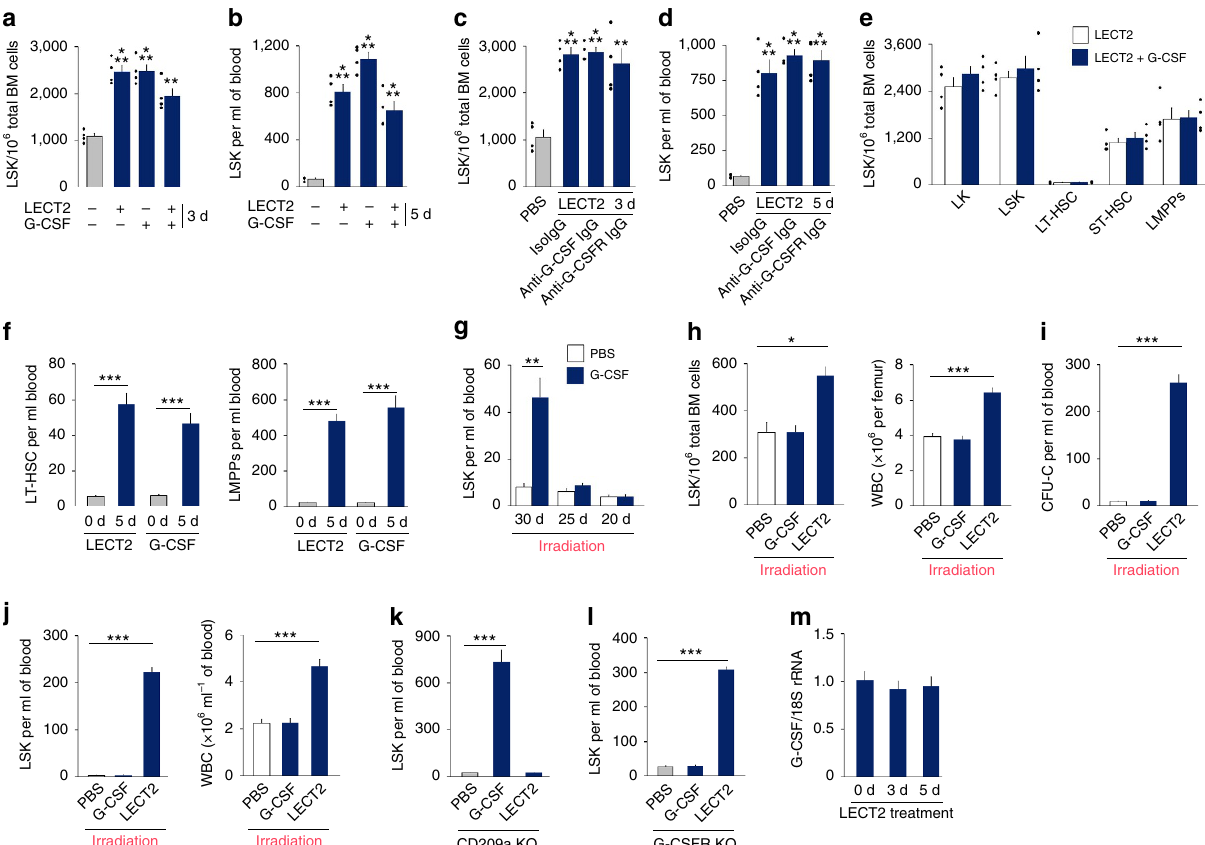
Figure 8 | LECT2 and G-CSF have independent effects on HSCs. ( a , b ) The number of LSK cells in BM or blood after PBS, LECT2, G-CSF or LECT2 þ G-CSF treatment. ( c , d ) LSK cell number in the BM or blood of mice treated with PBS or LECT2 combined with isoIgG, anti-G-CSF IgG or anti-G-CSFR IgG. ( e ) The number of LK cells, LSK cells, LT-HSCs, ST-HSCs and LMPPs in BM following LECT2 or LECT2 þ G-CSF treatment; n ¼ 4. ( f ) The number of LT-HSCs and LMPPs in the blood following LECT2 or G-CSF treatment. ( g ) LSK cell number in irradiated mice (6Gy) after G-CSF treatment at different time points. ( h ) The number of LSK cells and WBCs in the BM of irradiated mice 20 days after G-CSF or LECT2 treatment. ( i , j ) The number of CFU-Cs, LSK cells and WBCs in the blood of irradiated mice 20 days after G-CSF or LECT2 treatment. ( k ) The effect of G-CSF or LECT2 on the number of LSK cells in CD209a KO mice. ( l ) The effect of G-CSF or LECT2 on the number of LSK cells in G-CSFR KO mice; n ¼ 5. ( m ) mRNA expression of G-CSF after LECT2 treatment. The small black dots in histograms are data points. The data represent means ± s.e.m. The data are representative of two independent